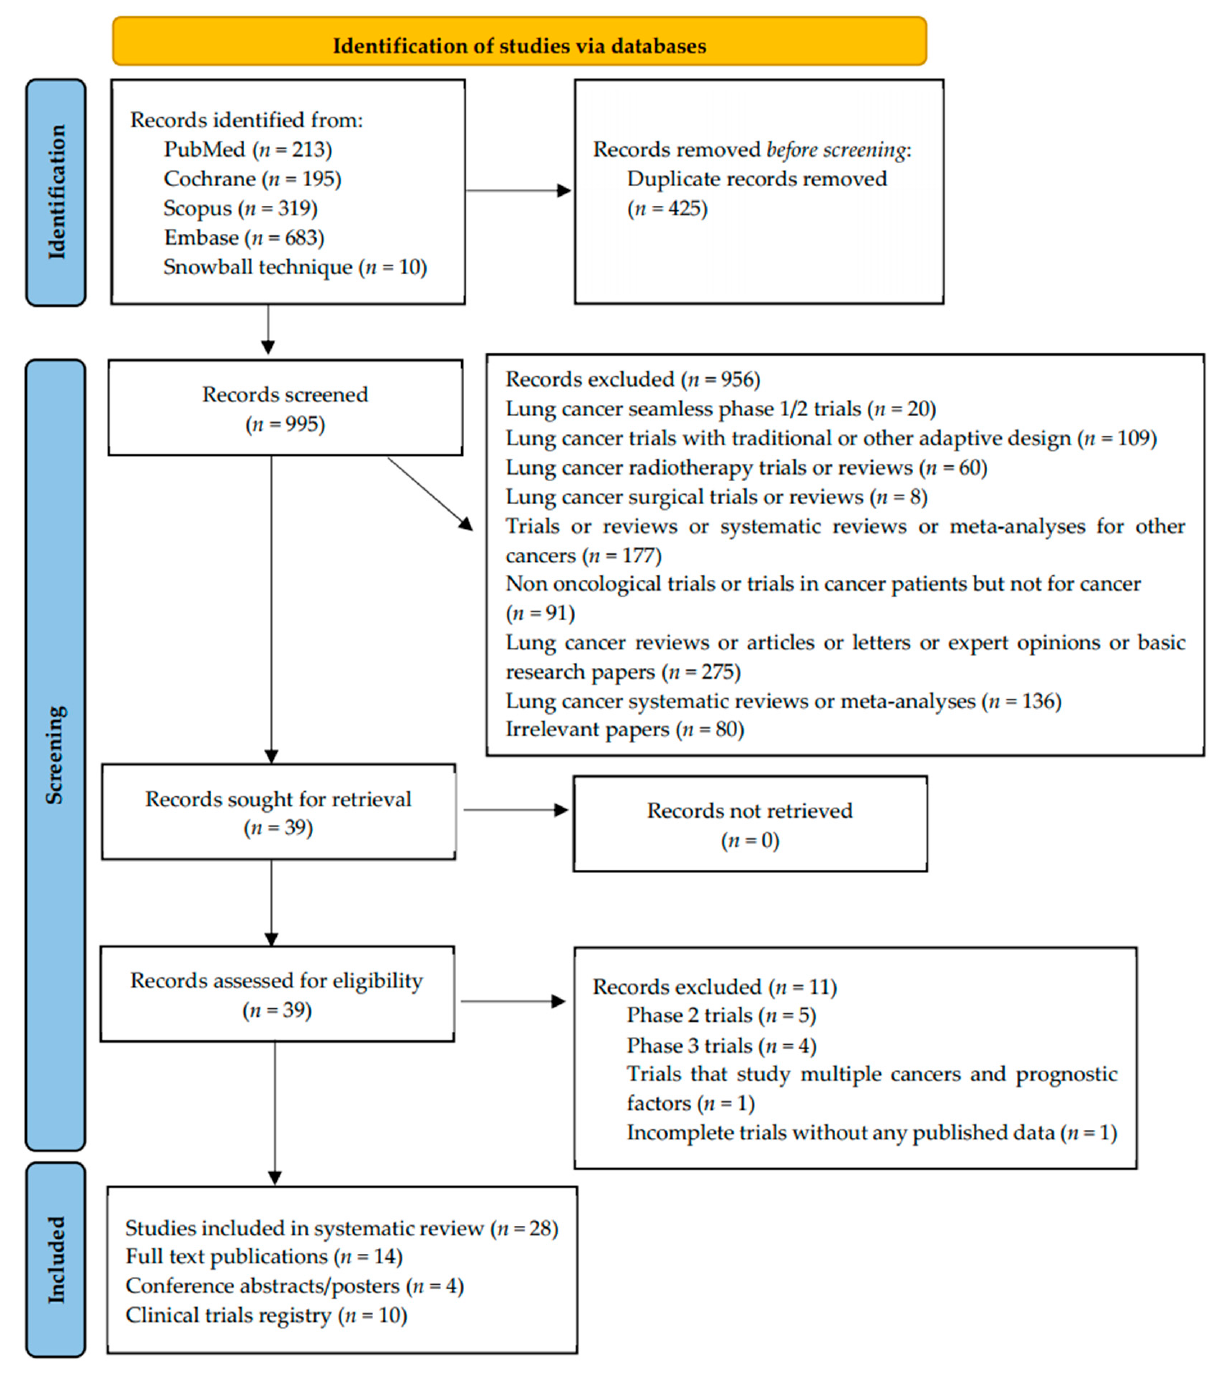
Figure 1. Modified PRISMA_2020 flow diagram of the systematic review.